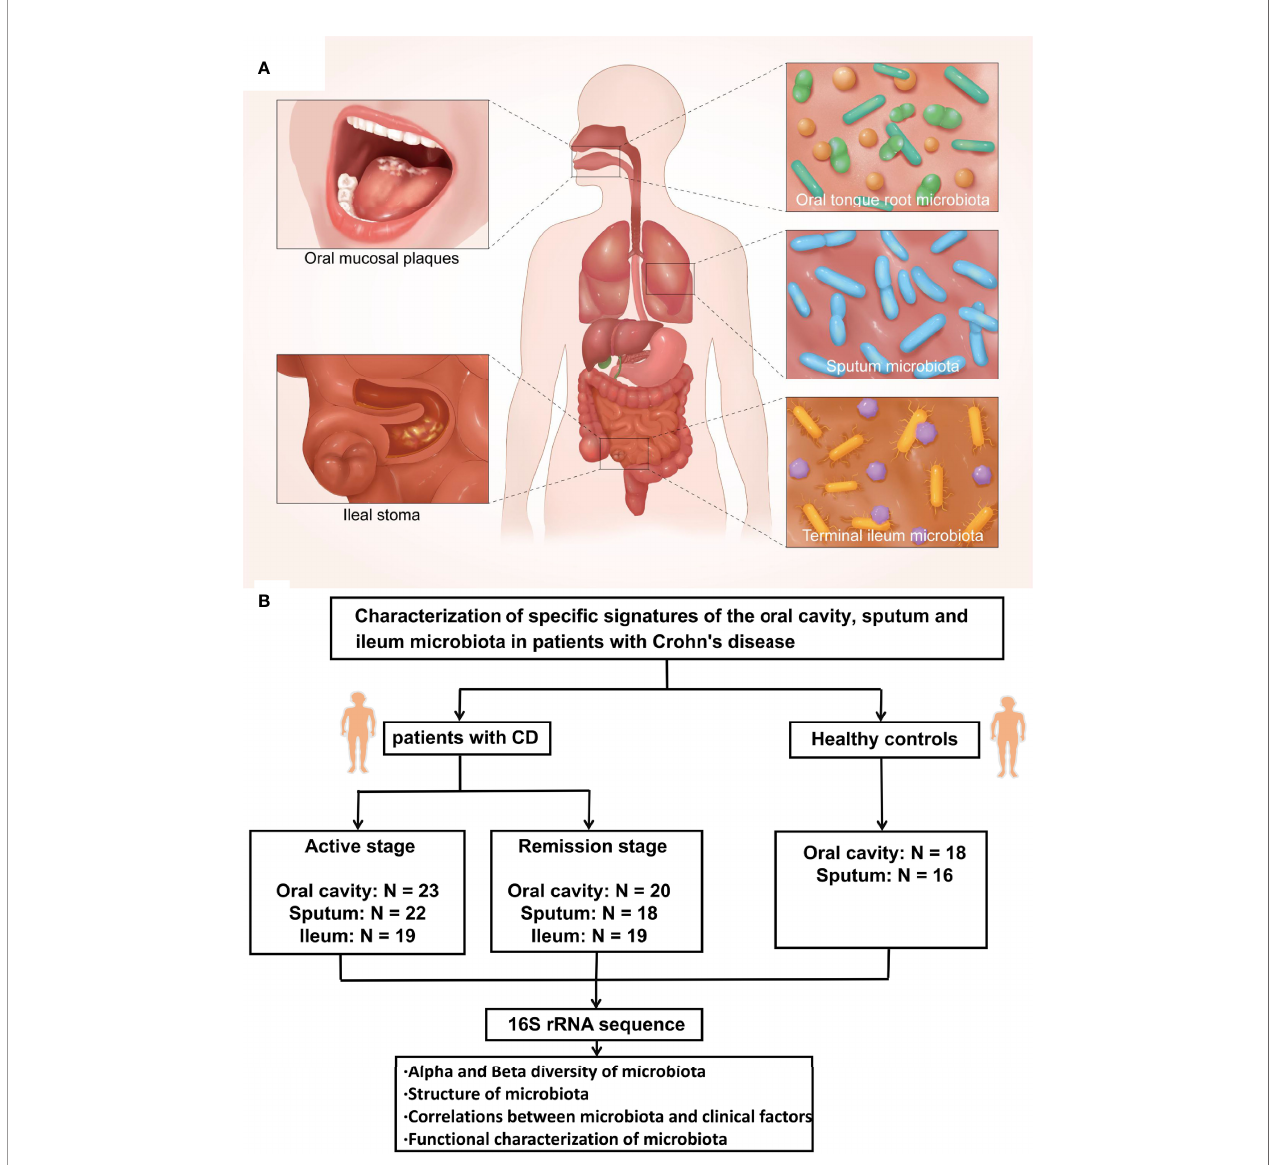
FIGURE 1 | Human body model diagram and experimental fl ow diagram. (A) Microbial samples were collected from the tongue base, sputum and ileal stoma. (B) Microbial samples from the oral cavity, sputum, and ileum were collected from patients with CD in the active and remission stages and healthy controls. The microbial composition was assessed by 16S rRNA gene sequencing. Bioinformatics methods were used to demonstrate the alpha and beta diversity of microbiota, the structure of microbiota, correlations between microbiota and clinical factors, and functional characterization of